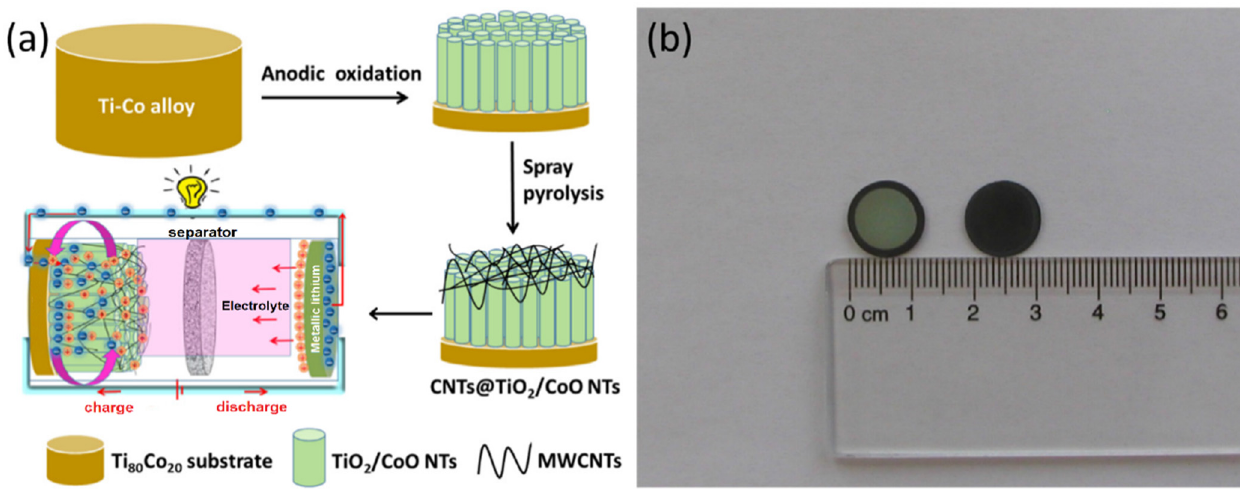
Figure 6. ( a ) Schematic illustration of the fabrication strategy of ternary CNTs@TiO 2 /CoO NTs; ( b ) photograph of the TiO 2 /CoO NT before (left electrode) and after CNT covering (right electrode). Figure adapted from [59] .